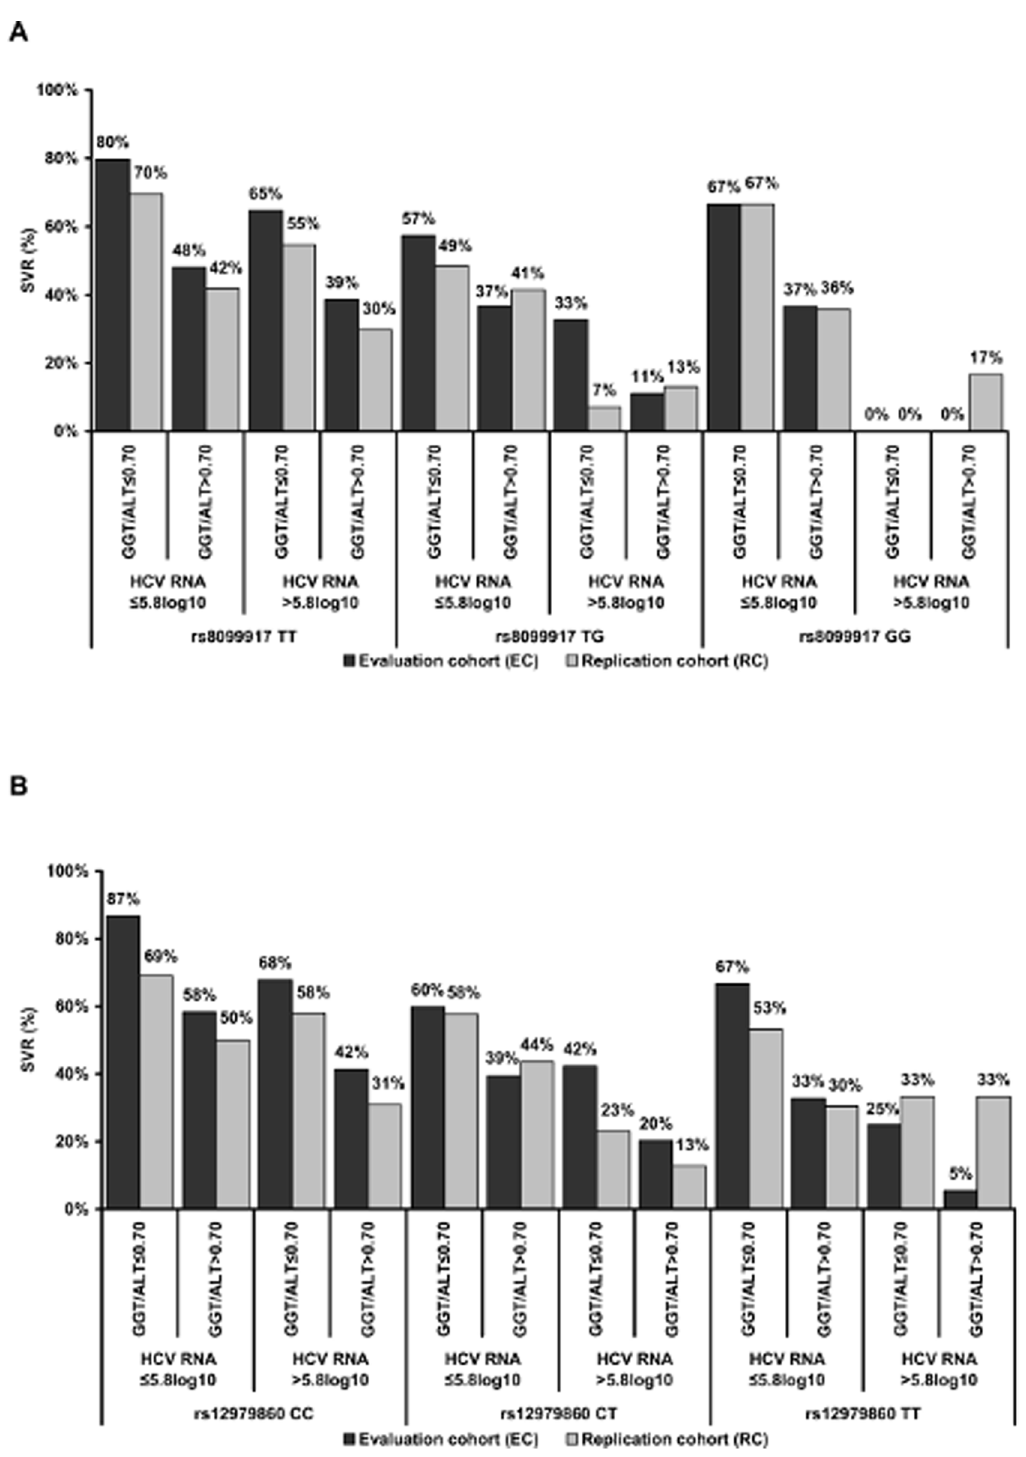
Figure 3. Combined determination of IFNL3 variants, GGT/ALT ratio and HCV RNA levels improved sustained virologic response (SVR) rates. SVR rates in the evaluation (EC) and replication cohort (RC) according to IFNL3 ( A ) rs12979860 and ( B ) rs8099917 genotypes after adjustment for the GGT/ALT ratio (cut-off value 0.70) and HCV RNA concentration (cut-off value 5.8log 10 ). doi:10.1371/journal.pone.0077530.g003 prediction by combining baseline parameters with the genetic informative [30–32]. However, there is evidence that IFNL4 might variants might vary. Especially in patients with Afro-American even affect HCV clearance and treatment prediction in patients of ancestry the determination of IFLN4 might be clearly more European descent [52]. Therefore, further research is required to